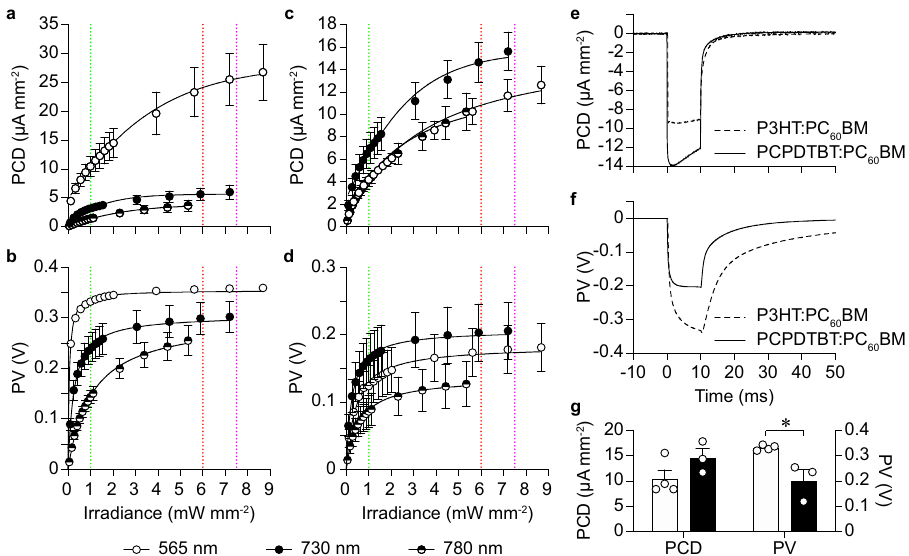
Fig. 2 Optimization of the bulk heterojunction. a , b Mean (±s.e.m., n = 4 chips) PCD ( a ) and PV ( b ) with HTL/P3HT:PC 60 BM/Ti. c , d Mean (±s.e.m., n = 3 chips) PCD ( c ) and PV ( d ) with HTL/PCPDTBT:PC 60 BM/Ti. In a – d , the vertical dotted lines represent the normalized irradiance levels respectively for 565 nm (green, 1 mWmm − 2 ), 730 nm (red, 6 mWmm − 2 ), and 780 nm (magenta, 7.5 mW mm − 2 ). The solid lines are the interpolations with an asymmetrical, fi ve-parameter, logistic dose-response function for PCDs and a hyperbola function for PVs. e , f Grand-average PCD ( e ) and PV ( f ) traces with HTL/P3HT: PC 60 BM/Ti (dashed line, 565 nm, n = 4 chips) and HTL/PCPDTBT:PC 60 BM/Ti (solid line, 730 nm, n = 3 chips) BHJs respectively at their normalized irradiance levels. g , Mean (±s.e.m.) PCD and PV obtained with HTL/P3HT:PC 60 BM/Ti (white bars, 565 nm, n = 4 chips) and HTL/PCPDTBT:PC 60 BM/Ti (black bars, 730 nm, n = 3 chips) respectively at their normalized irradiance